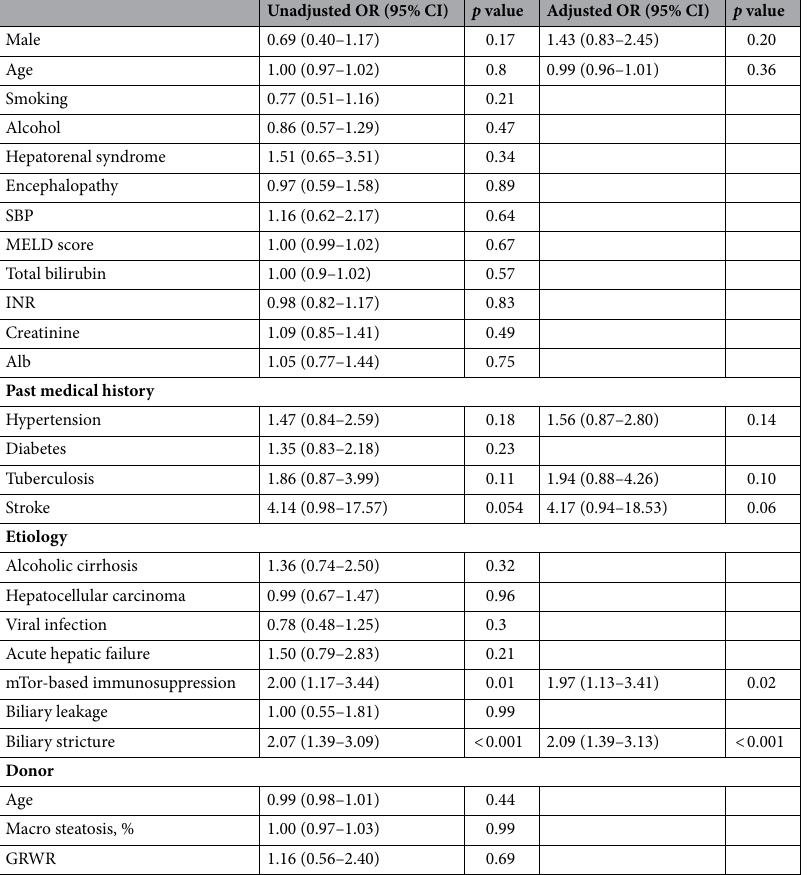
Table 4. Predictors of hypercholesterolemia within 1-year after living donor liver transplantation. SBP spontaneous bacterial peritonitis, MELD model for end-stage liver disease, INR international normalized ratio, GRWR graft-to-recipient weight ratio, OR odds